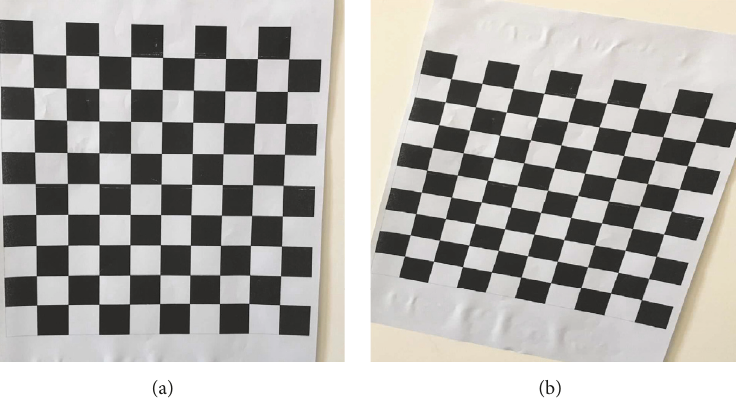
Figure 6: (a) and (b) are two images of the checkerboard, respectively.